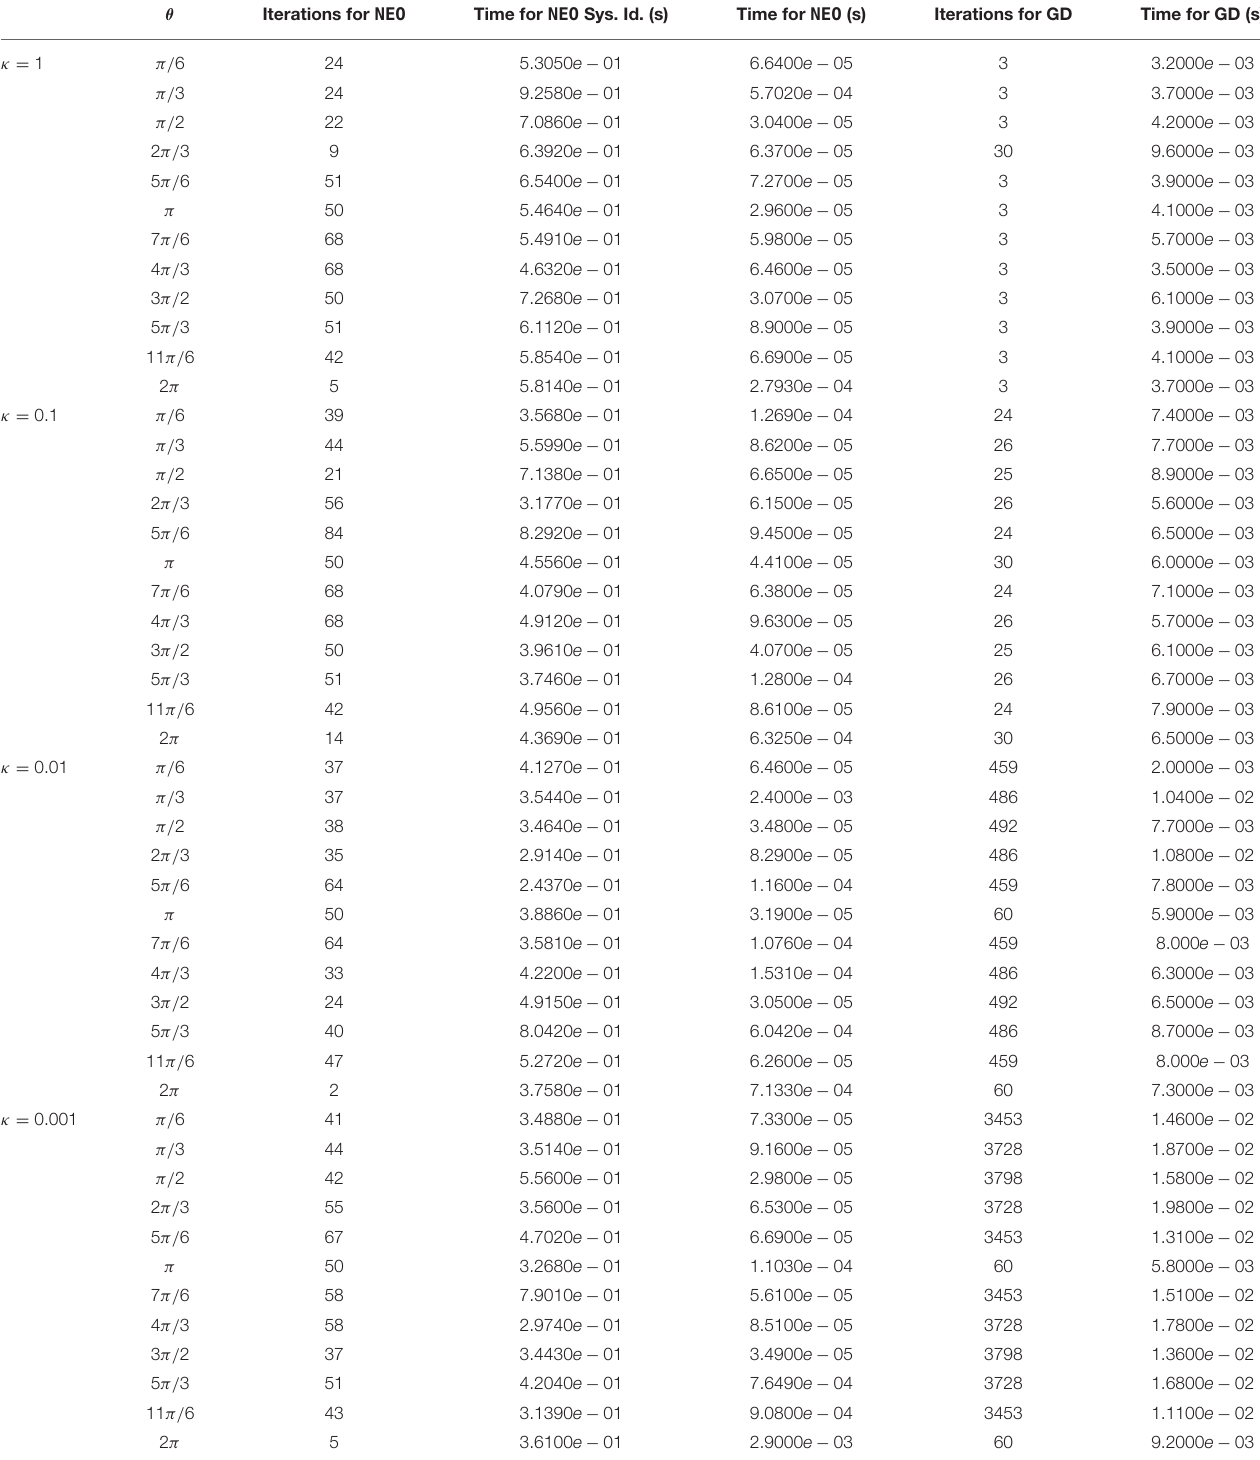
TABLE 1 | Iterations taken to convergence to find the minimum of f ( x , y ) x 0 [cos θ sin θ ] T , for values of κ in the set = same starting point in each row). ARFIMA(4, d ,0) time series predictions are used in our method for each